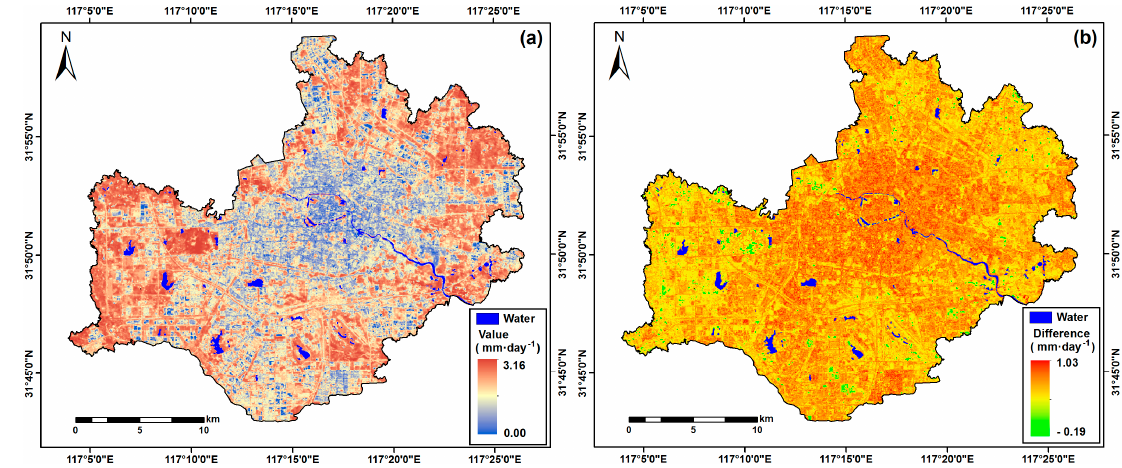
Figure 15. ( a ) The spatial variability of daily evapotranspiration of Hefei’s urban built-up area on 13 October 2013, inferred from Zheng’s model; ( b ) the difference between the results of our model and Zheng’s model.